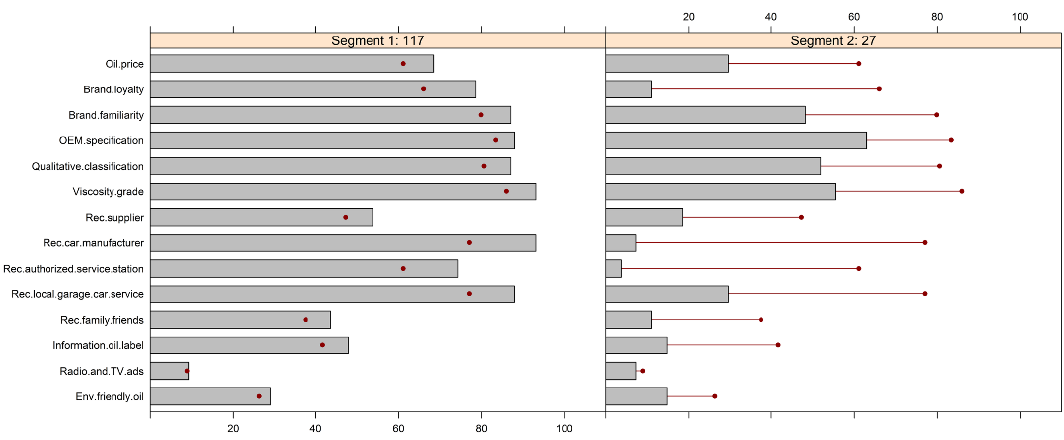
Table 1. Distribution of drivers’ propensity to buy environmentally friendly engine oil conditionally on the declared importance of the low oil price .